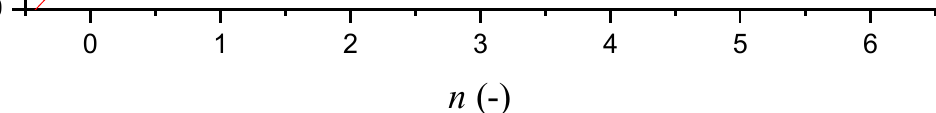
Figure 4. Dependence of ultrasonic speed UZ vlnM on the number of extrusions n